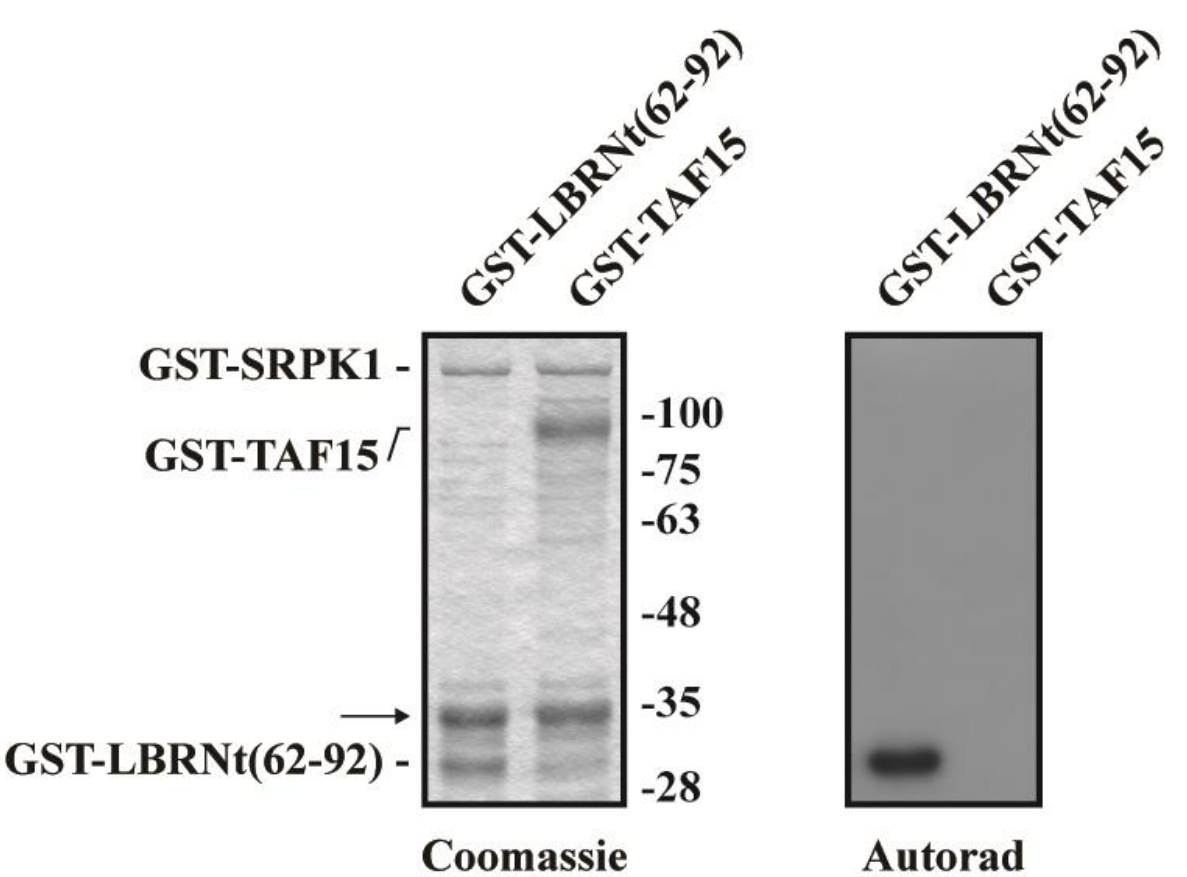
Figure 2. TAF15 is not a substrate of SRPK1. Phosphorylation of GST-LBRNt(62–92) and GST-TAF15 by GST-SRPK1. The band indicated by the arrow represents a GST-SRPK1 degradation product. Left panel, Coomassie blue staining; right panel, auto-radiography.